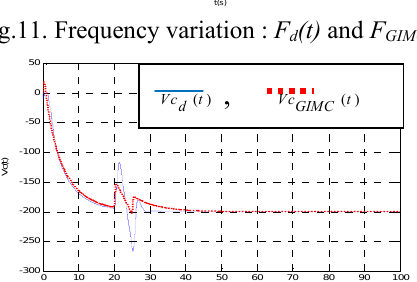
Fig.11. Frequency variation : F